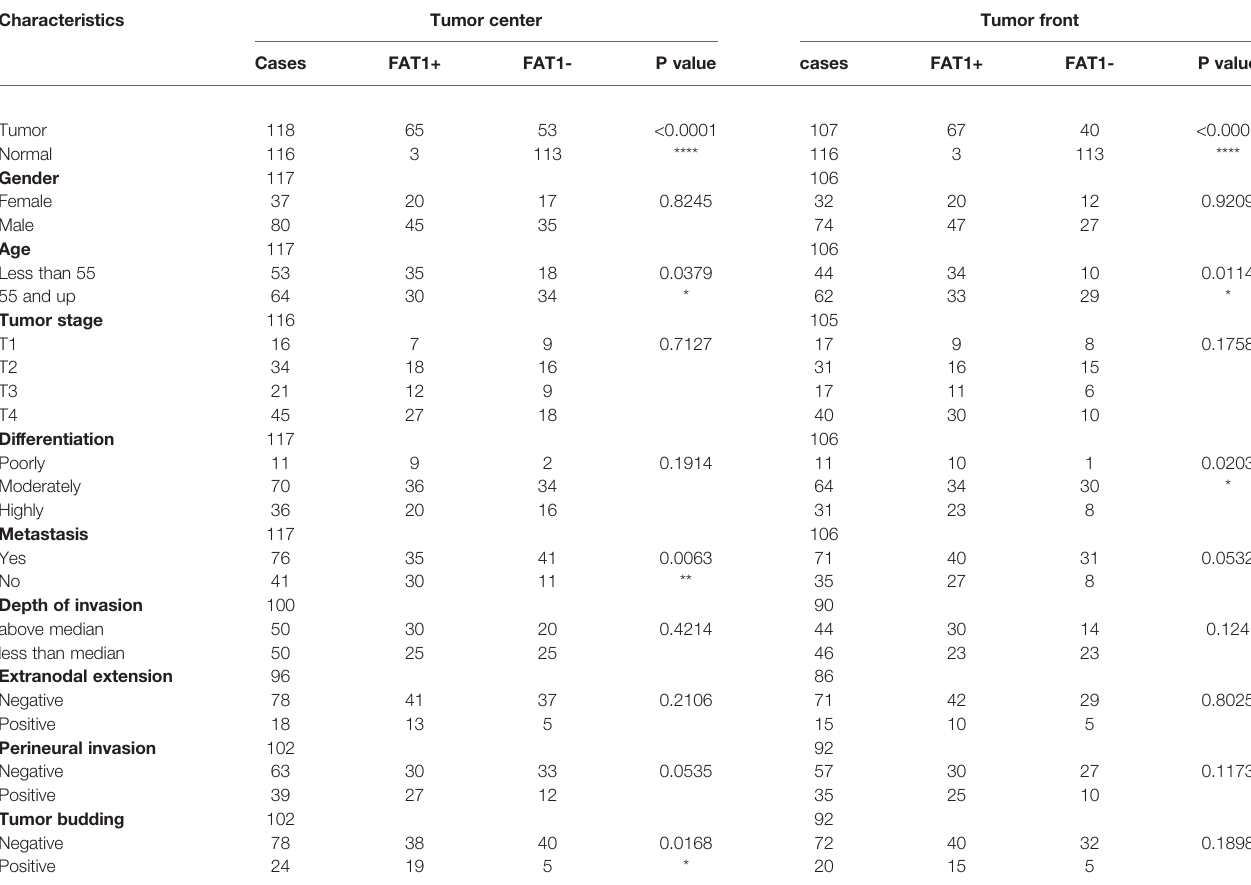
TABLE 2 | Expression levels of FAT1 in OSCC samples with different clinical and pathological characteristics.